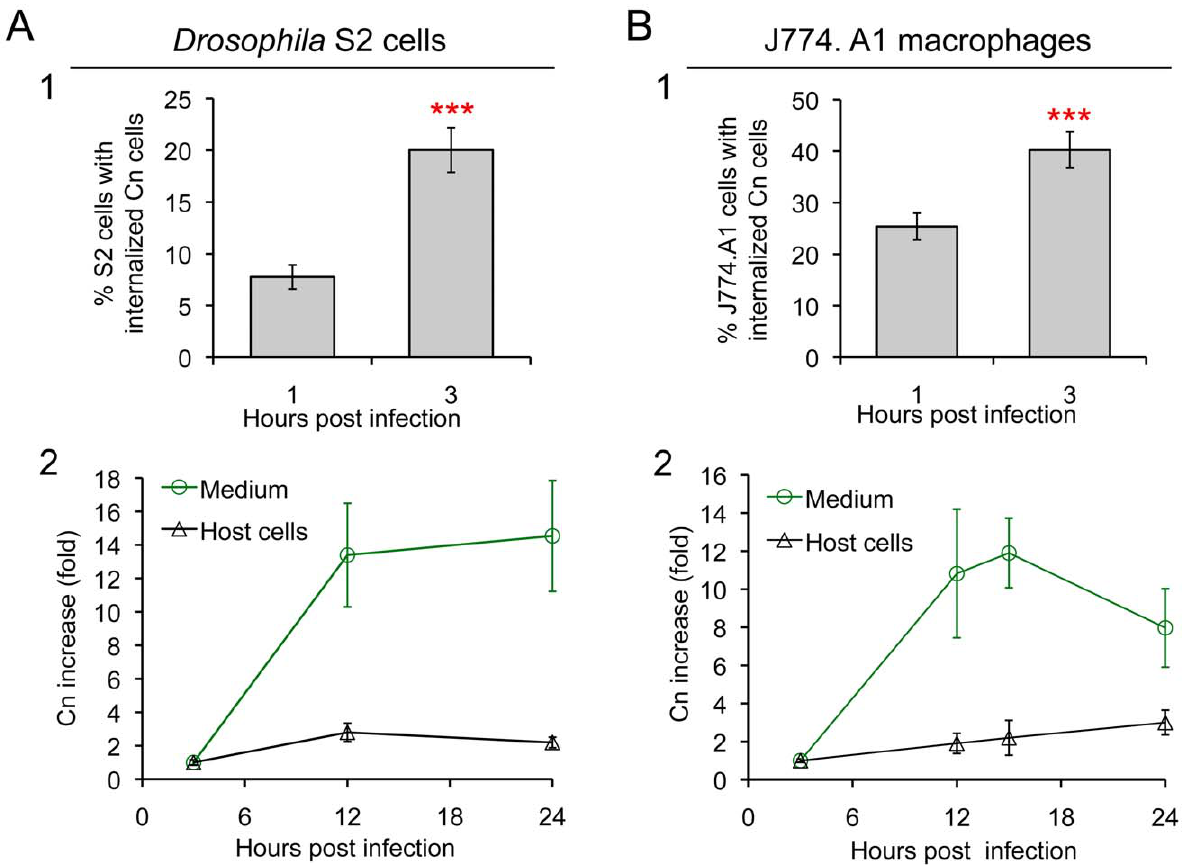
Figure 2. Drosophila S2 cells and murine J774.A1 macrophages support similar patterns of Cn phagocytosis and intracellular replication. A1 and B1 . Host cell phagocytosis of Cn cells. Infected S2 and J774.A1 cells (on coverslips in 24-well plates) were extensively washed after coincubation with Cn (AI100-dsRed) cells for 1 or 3 hrs. The infected cells were fixed, stained with rhodamine-phalloidin and then analyzed by fluorescence microscopy. The numbers of Cn within host cells were quantified, and the percentages of host cells that had been phagocytosed at the indicated time points post-infection were determined. For each well in each experiment, at least 500 cells were analyzed. A2 and B2 . Host cells support Cn intracellular replication and escape from infected cells. At 3 h.p.i., Cn (AI100-dsRed) infected host cells were extensively washed. Fresh medium supplemented with 20 m g/ml fluconazole was added to each well containing infected host cells. The infected cells were then continuously incubated at 28 u C (S2 cells) or 37 u C, 5% CO 2 (J774.A1 macrophages). At the indicated time points, media were collected from each well to determine the number of Cn cells that had escaped. The number of CFUs recovered from each sample was then quantified, and the fold-increase of Cn cells (compared to the initial amount recovered at 3 h.p.i.) was calculated and plotted as a function of time. In parallel, at various times post-infection, the corresponding infected S2 and J774.A1 cells were lysed and the number of CFUs contained therein determined after plating and growth on solid medium. The fold-increase of Cn cells was then calculated and plotted (black line) as above. Data represent means 6 standard deviation (SD) from at least three independent experiments in which triplicate wells were analyzed.